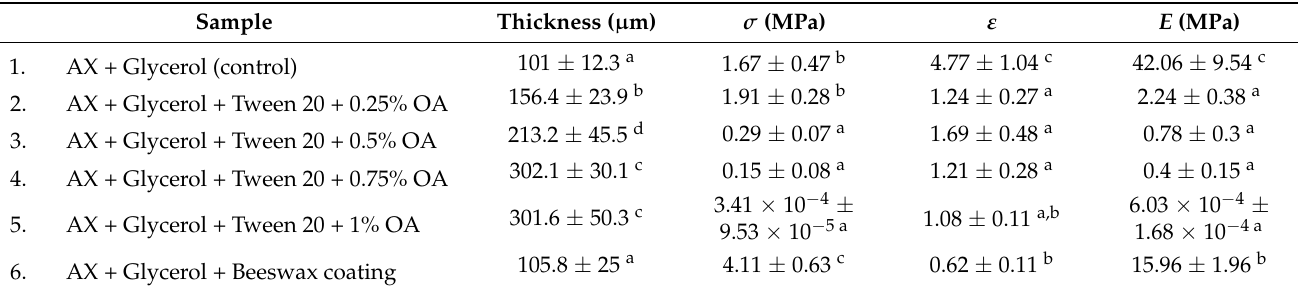
Table 11. Thickness ( µ m), tensile stress at break ( σ , MPa), elongation at break ( ε ), and Young’s modulus (E, MPa) of all film samples. Values in the same column followed by different superscript letters differ significantly ( p <